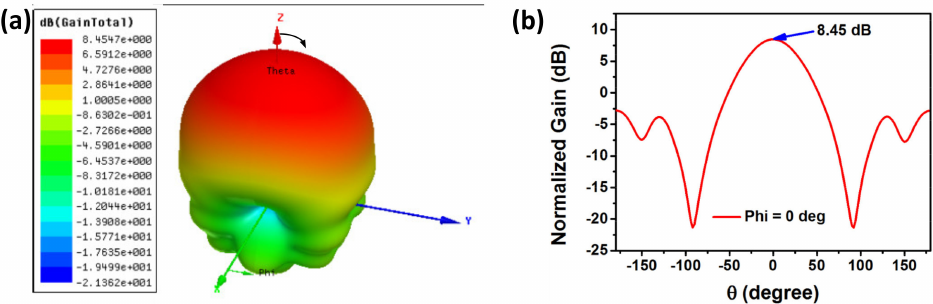
Figure 5. ( a ) 3D gain sphere. ( b ) Simulated radiation pattern when Phi = 0 degree.